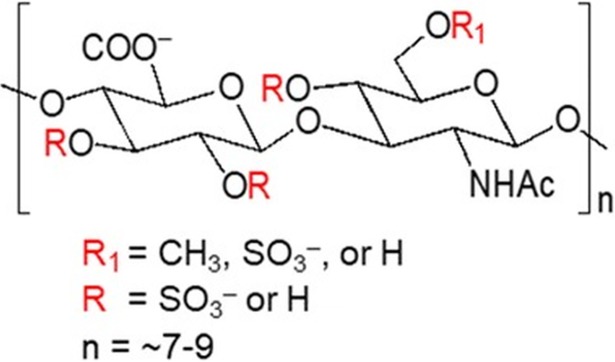
The chemical structure of synthetic glycosaminoglycan, GM-1111.